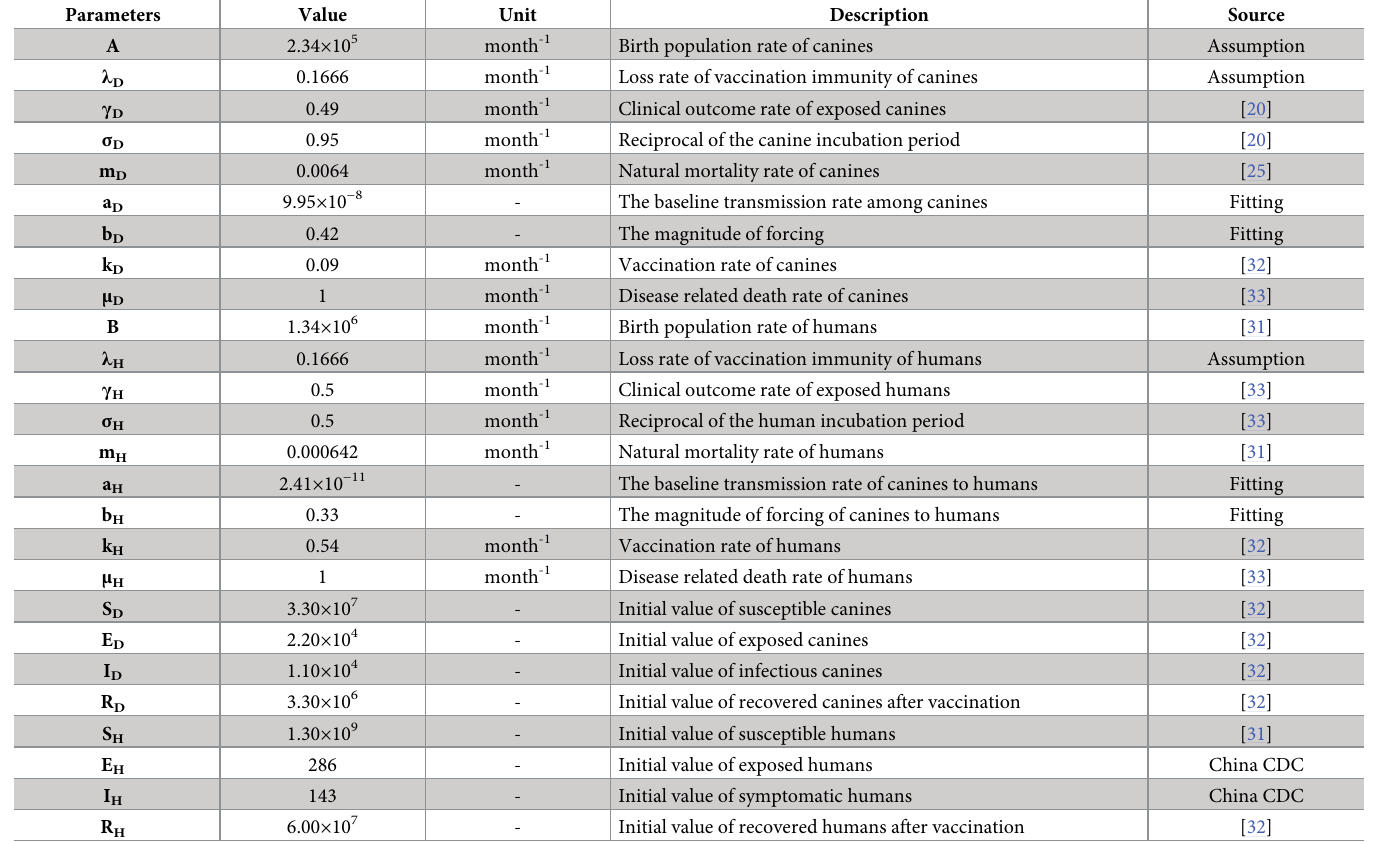
Table 1. Descriptions and values of parameters in model (1).